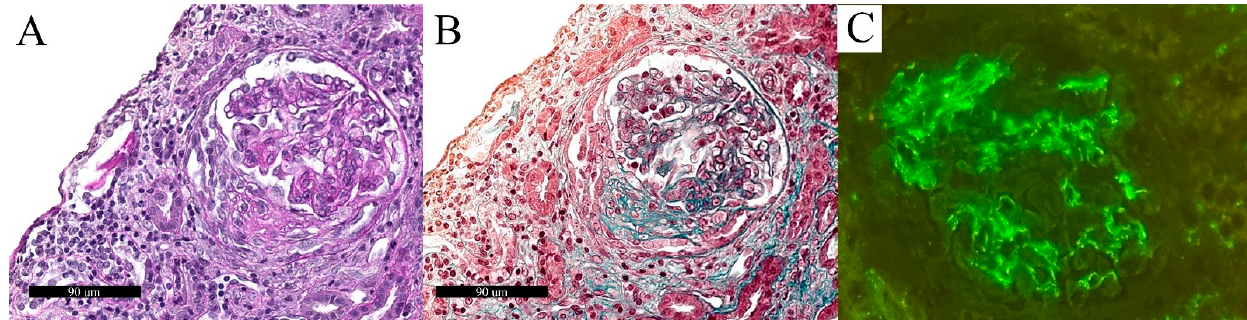
Figure 4. Ultrastructural features of MCD. Case 5 ( A ), Case 6 ( B ), Case 7 ( C ), and Case 8 ( D ) pre- sented features of diffuse